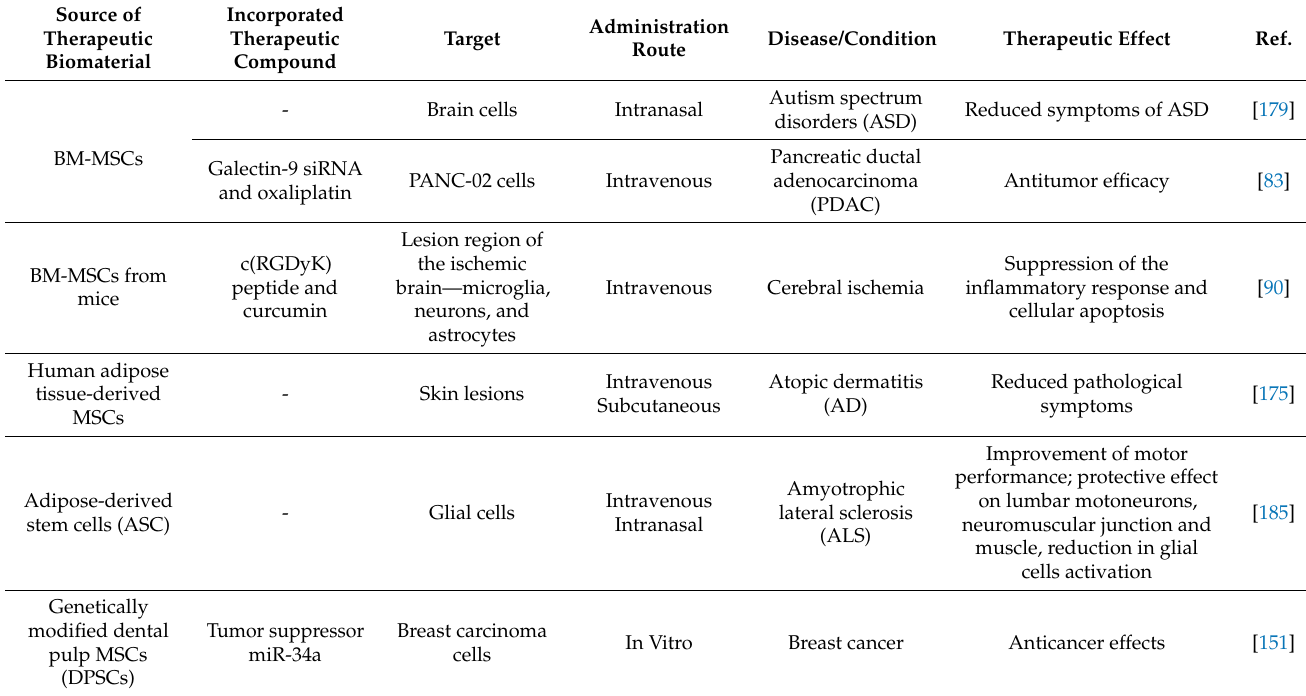
Table 4. Drug delivery through different administration routes for various therapeutic